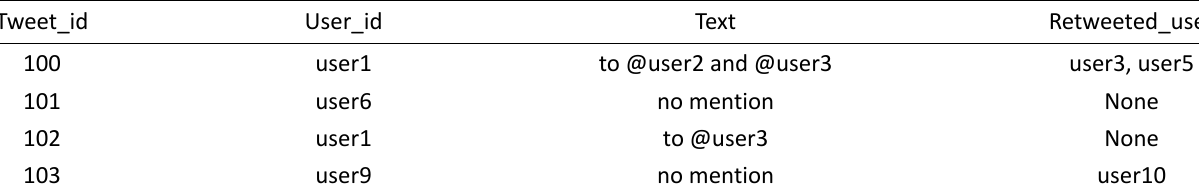
Table 2. Sample Twitter data.